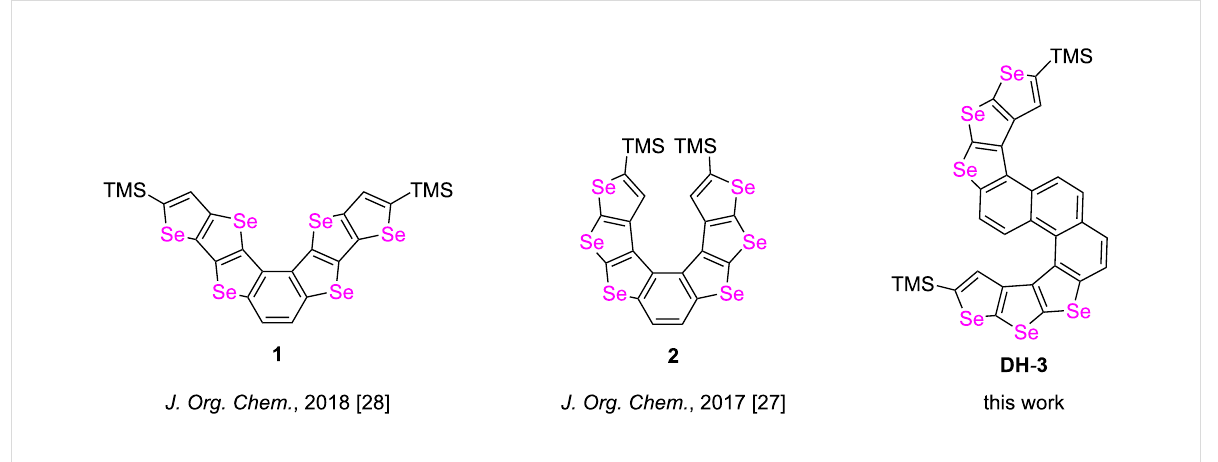
Figure 1: Molecular structures of bull horn-shaped heteroacene 1 , selenophene-based [7]helicene 2 and novel compound DH - 3 .